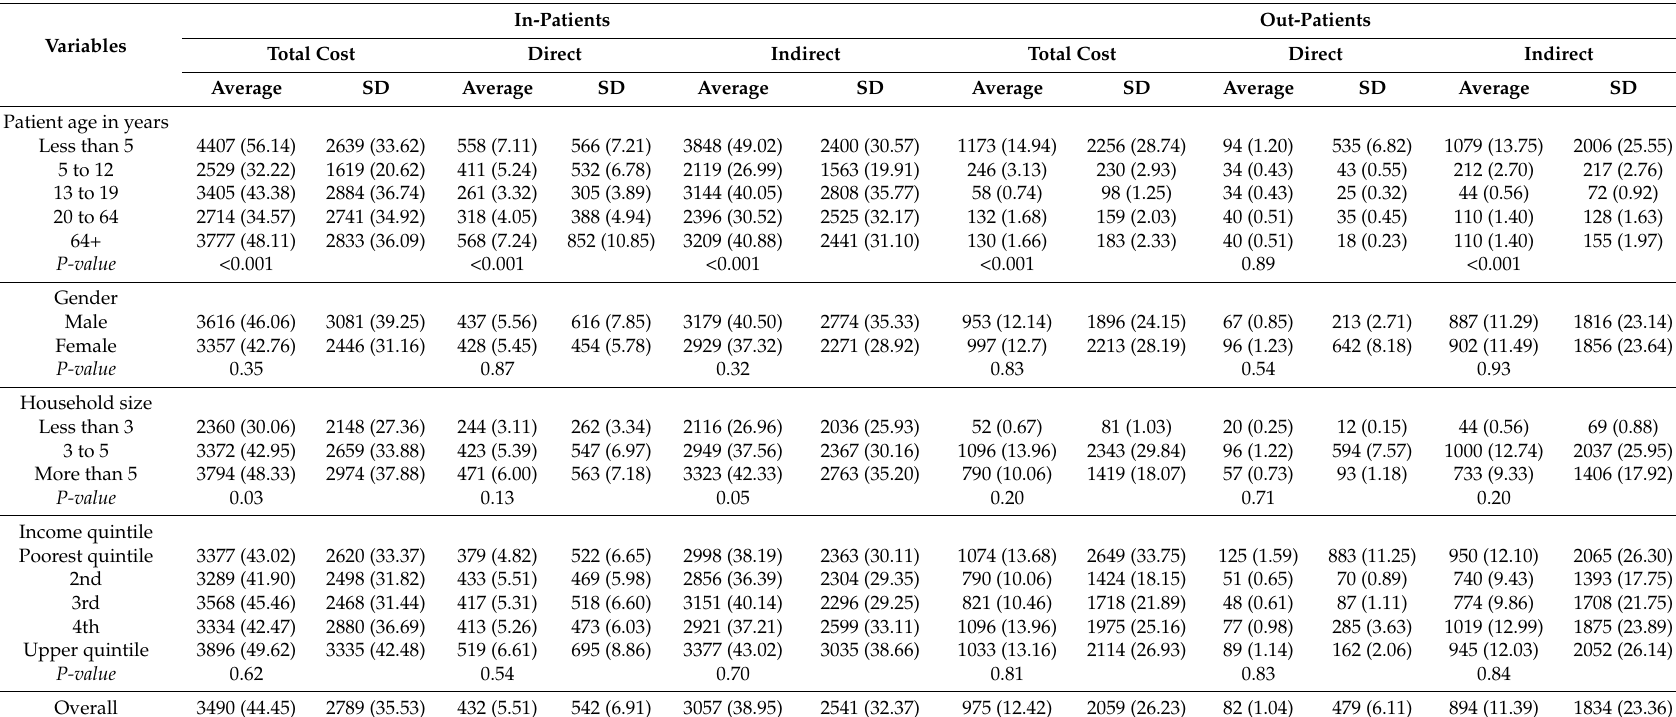
Table 3. Distribution of average care giver expenditure by socio-demographic characteristics ( N = 801), BDT,